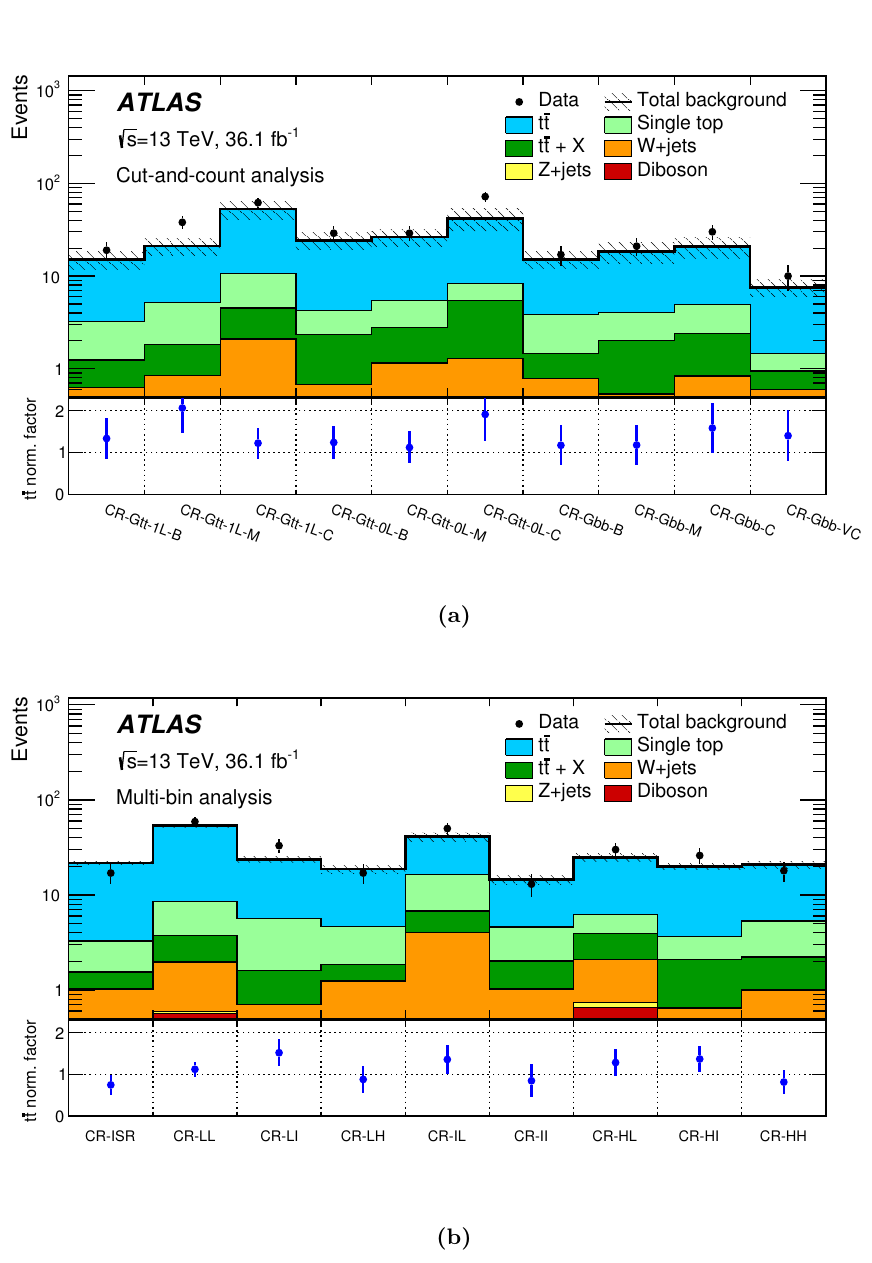
Figure 7. Pre-(cid:12)t event yield in control regions and related t (cid:22) t normalization factors after the background-only (cid:12)t for (a) the cut-and-count and (b) the multi-bin analyses. The upper panel shows the observed number of events and the predicted background yield before the (cid:12)t. The background category t (cid:22) t + X includes t (cid:22) tW=Z , t (cid:22) tH and t (cid:22) tt (cid:22) t events. All of these regions require at least one signal lepton, for which the multijet background is negligible. All uncertainties describes in section 7 are included in the uncertainty band. The t (cid:22) t normalisation is obtained from the (cid:12)t and is displayed in the bottom